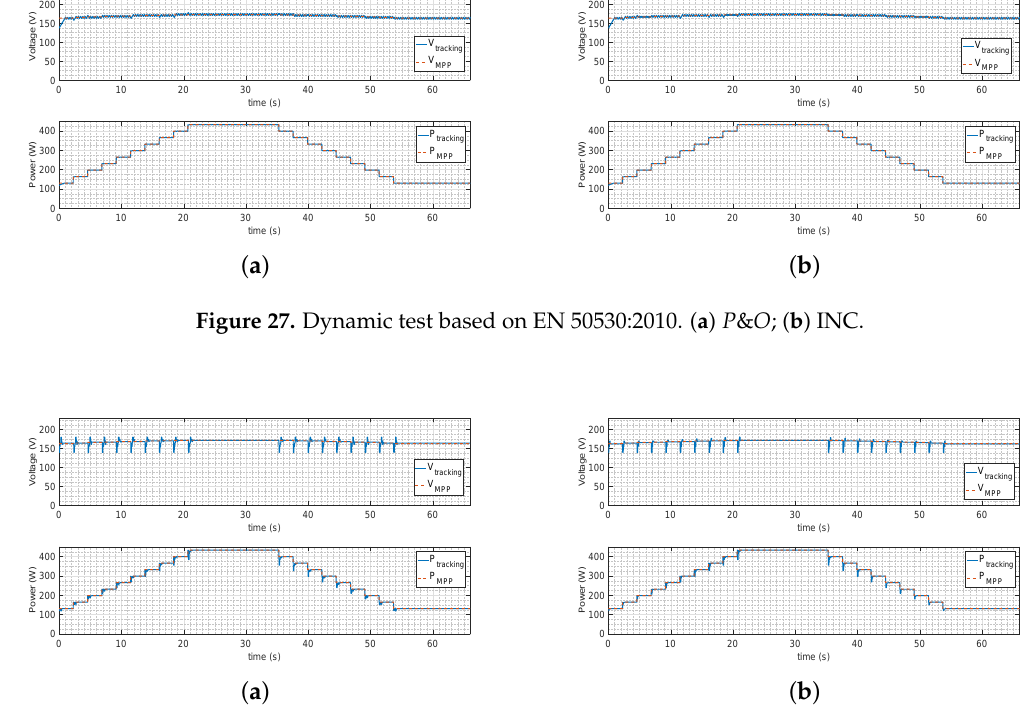
Figure 28. Dynamic test based on EN 50530:2010. ( a ) GSS; ( b )